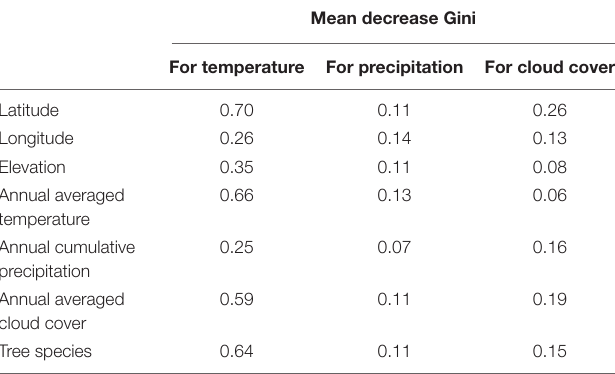
TABLE 5 | Mean Gini coefficient decrease for geographical (latitude, longitude, and elevation), climatological (annual averaged temperature and cloud cover, and annual cumulative precipitation), and biological (tree species) characteristics in random forest models limited to the Pinus tree genus explaining the response function coefficients of the RWI with autumn climate